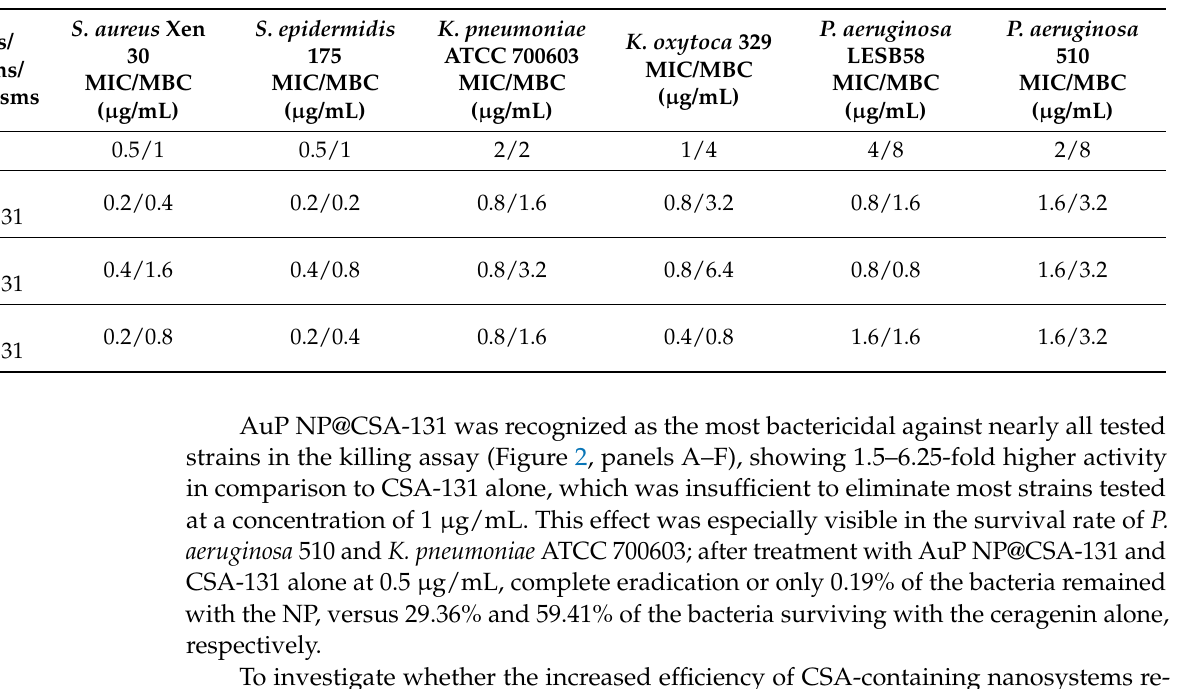
Table 6. MIC and MBCs values of CSA-131, AuR NP@CSA-131, AuP NPs@CSA-131, and AuS NP@CSA-131 against the studied strains of